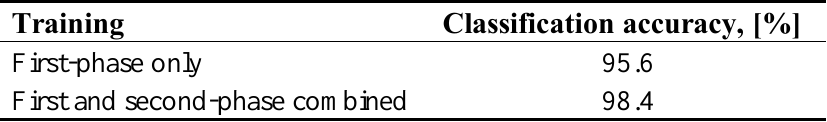
Table 6. Sequential classifiers classification accuracy.